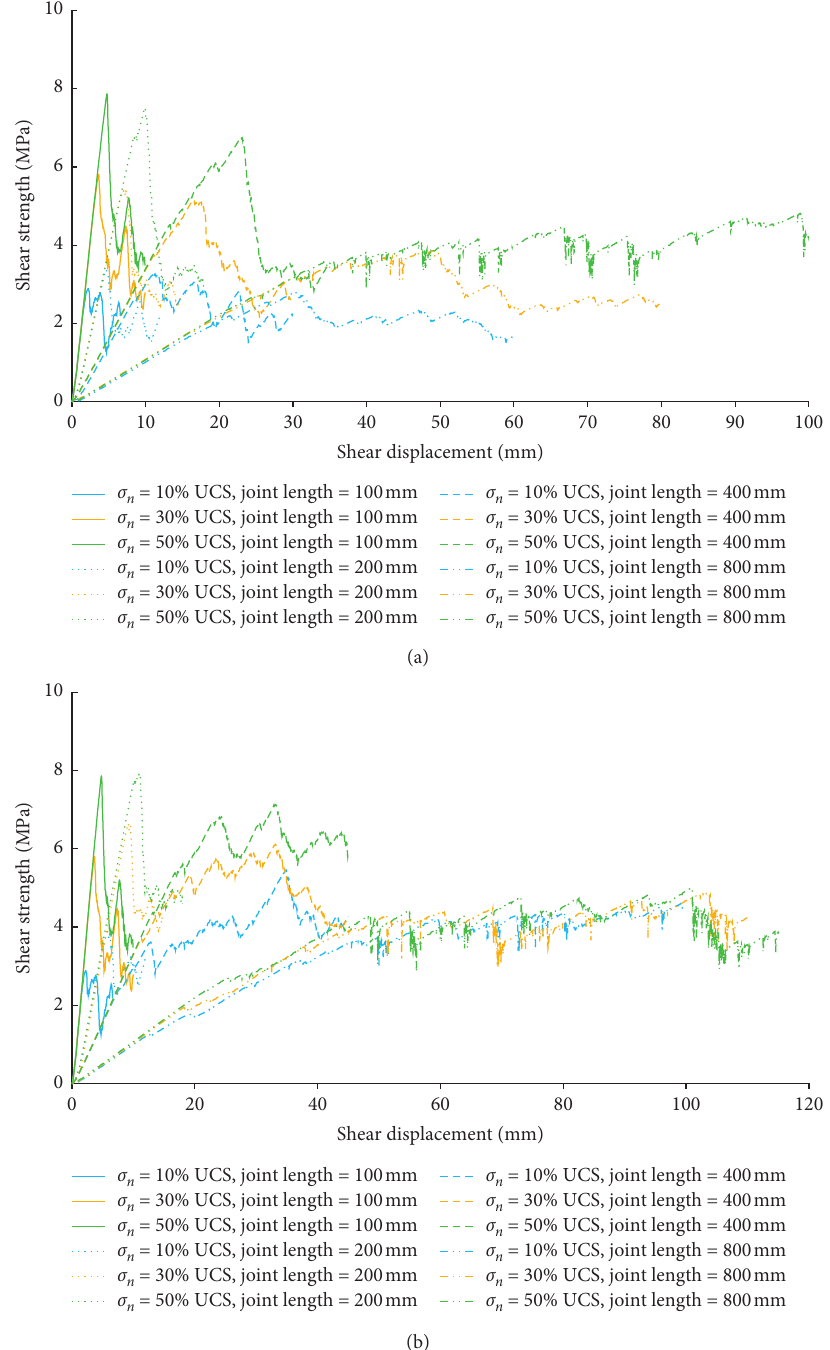
Figure 10: Shear stress-shear displacement curves of different-sized rock joints under CND condition: (a) repeated and (b) enlarged rock joints derive from the tenth standard JRC